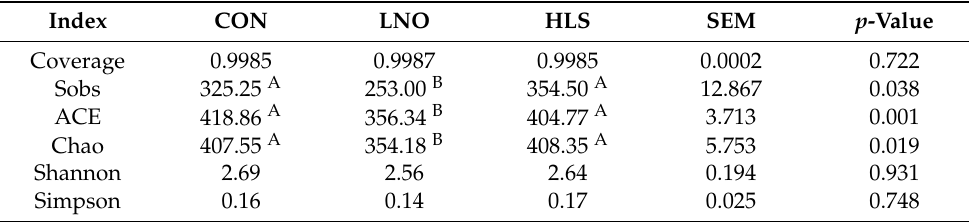
Table 7. The α -diversity indexes of bacteria in ileum